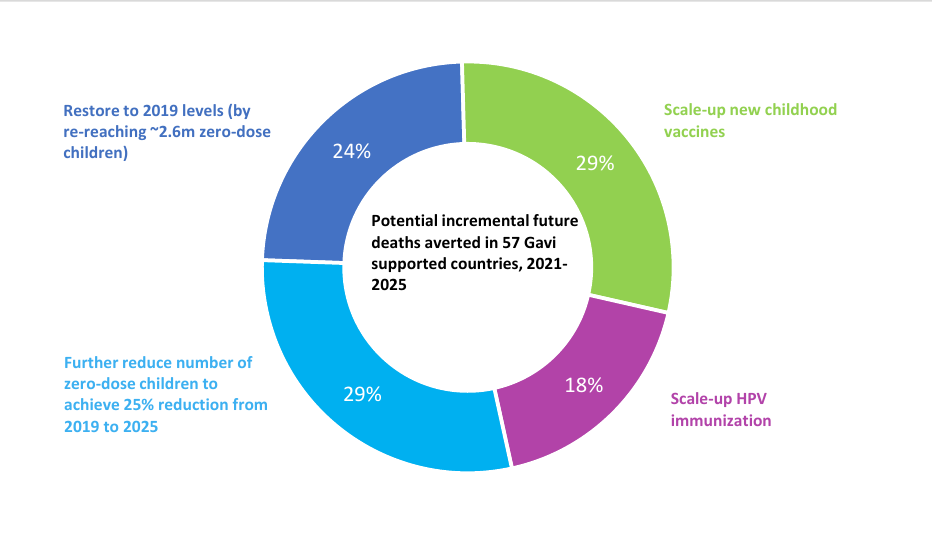
Figure 2. Potential incremental future deaths averted in 57 Gavi-supported countries through routine immunization, 2021–2025. Analysis based on Vaccine Impact Modeling Consortium impact ratios and immunization coverage as estimated in the WUENIC July 2021 release, ignoring the impact of maintaining coverage at 2020 levels and assuming Gavi 5.0 targets are met.